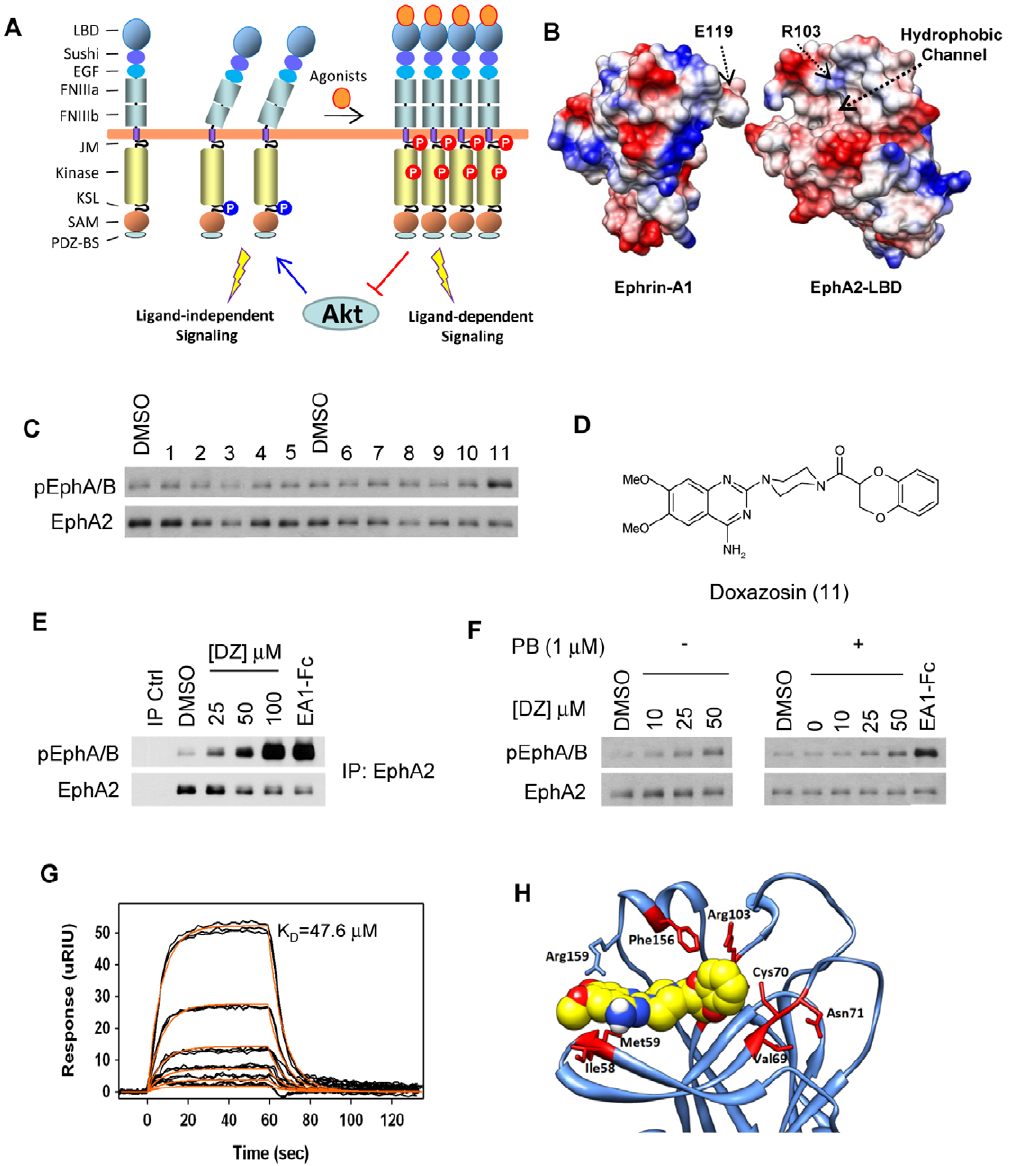
Figure 1. Insilico screening identifies doxazosin as a novel agonist for EphA2 receptor. (A) Schematic illustration of the predicted effects of small molecule agonists in inducing ligand-dependent signaling. (B) Crystal structure of the EphA2 ligand binding domain (LBD) in complex with ephrin-A1. Highlighted are the hydrophobic pocket and arginine 103 of the EphA2-LBD that interact with the G–H loop of ephrin-A1 and glutamate 119 of ephrin-A1, respectively. EphA2-LBD was rotated , 10 u counter-clockwise to better reveal the binding pocket. (C) Small molecule screening identifies doxazosin (Compound 11) as a novel EphA2 agonist. MDA-231-A2 cells were treated with Compounds 1–11 (50 m M in 0.2% DMSO) for 30 minutes and cell lysates were subject to immunoblot for phosphorylated EphA/B kinases (pEphA/B) and total EphA2. (D) Chemical structure of doxazosin (DZ). (E) Dose-response of EphA2 activation by DZ. MDA-231-A2 cells were treated with the indicated doses of DZ for 30 minutes and lysates were immunoprecipitated with an EphA2-specific antibody and blotted as in (C). Treatment with 1 m g/ml ephrin-A1-Fc (EA1-Fc) for 10 minutes served as a positive control. Note decreasing amount of EphA2 following ephrin-A1 and doxazosin treatment. (F) Immunoblots for pEphA/B on lysates from MDA-231-A2 cells pretreated with 1 m M phenoxybenzamine and then treated for 1 hour with indicated doses of DZ. Treatment with 1 m g/ml ephrin-A1-Fc (EA1-Fc) served as a positive control. Treatment with 0.2% DMSO for either 1 hour (left), or 5 hours (right) served as vehicle controls. (G) Representative plot from Surface Plasmon Resonance (SPR) analysis of DZ binding to the recombinant ligand binding domain of EphA2. Curves from bottom to top represent concentrations of 1.56, 3.13, 6.25, 12.5, 25, 50 m M. Determined K D value is shown within plot. (H) Molecular modeling of surface area diagram indicating amino acids of EphA2 potentially involved in direct interaction with doxazosin. The four amino acids of the ephrin-A1 loop are shown in red. Images were created using UCSF Chimera.